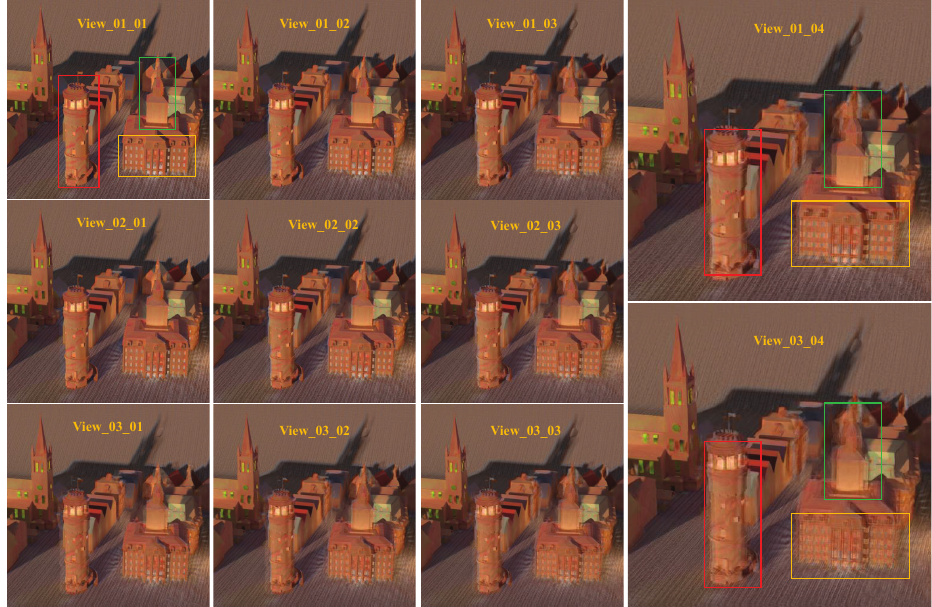
Figure 8. Results of light fields angular super-resolution on HCI dataset with high depth.